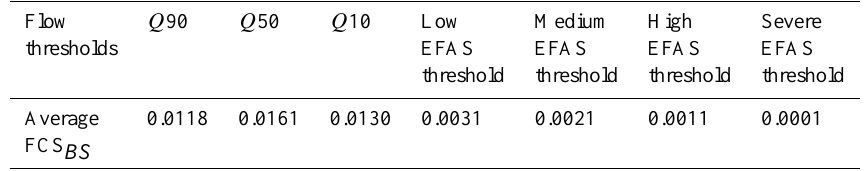
Table 1. Impact of different thresholds on FCS BS .